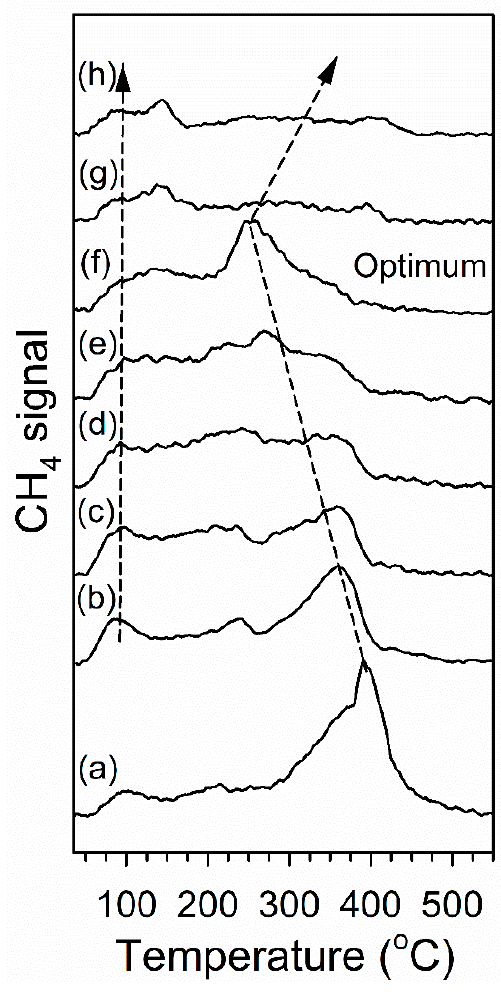
Figure 12. TP-reaction-MS of ethanol steam reforming over ( a ) 2% Pt/ZrO 2 , ( b ) 2.9% Cs-2% Pt/ZrO 2 , ( c ) 3.9% Cs-2% Pt/ZrO 2 , ( d ) 4.8% Cs-2% Pt/ZrO 2 , ( e ) 5.8% Cs-2% Pt/ZrO 2 , ( f ) 7.2% Cs-2% Pt/ZrO 2 , ( g ) 10.4% Cs-2% Pt/ZrO 2 , and ( h ) 14.5% Cs-2% Pt/ZrO 2 .